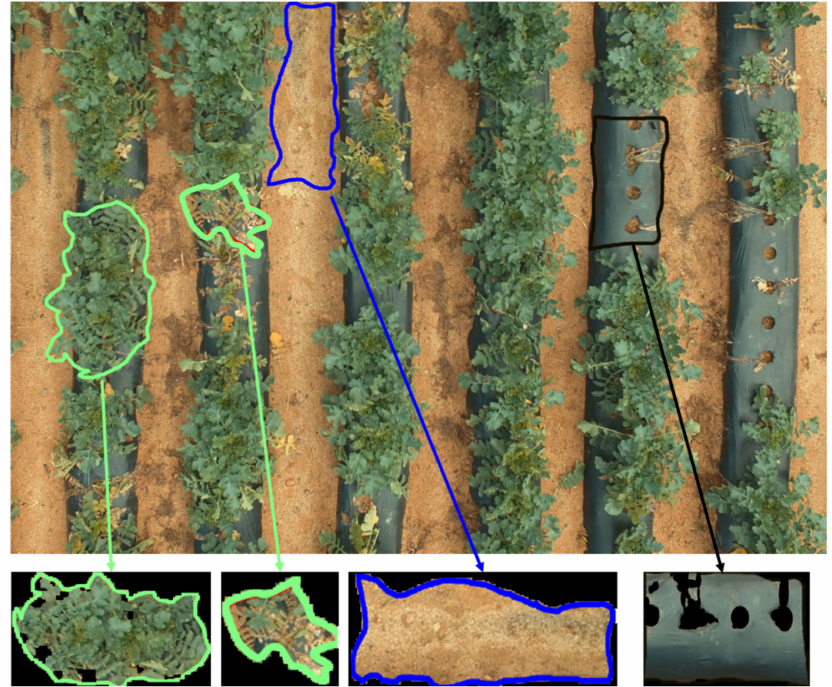
Figure 3. An RGB radish sample captured by UAV illustrates three distinctive types of objects (the green line shows radish regions, the blue line indicates soil, and the black line indicates plastic